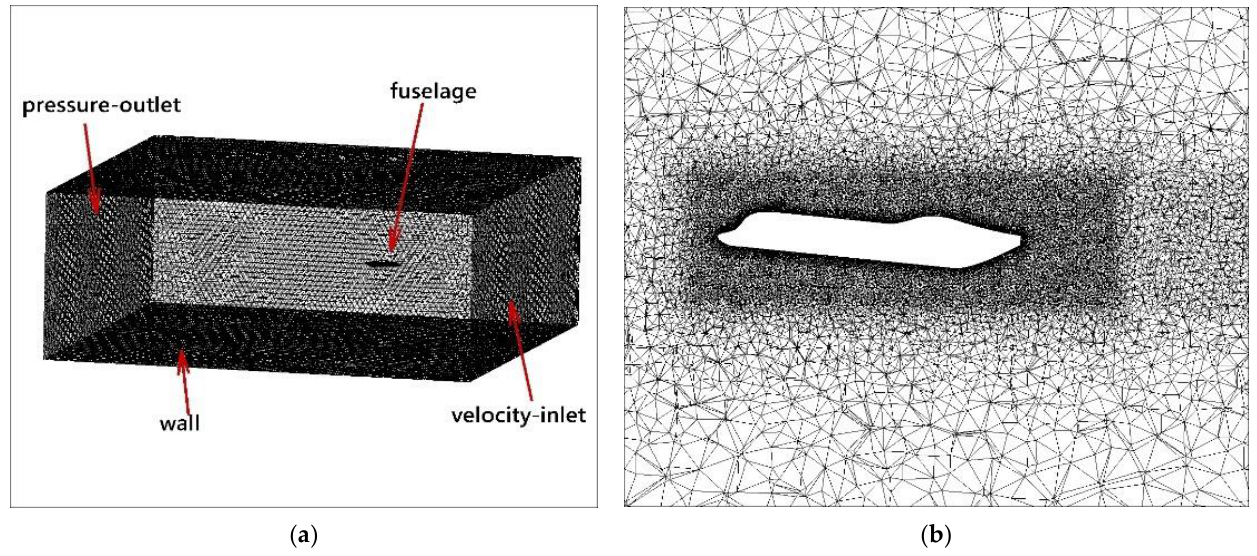
Figure 6. Numerical simulation of the fuselage aerodynamics. ( a ) Overall meshing. ( b ) Mesh details.